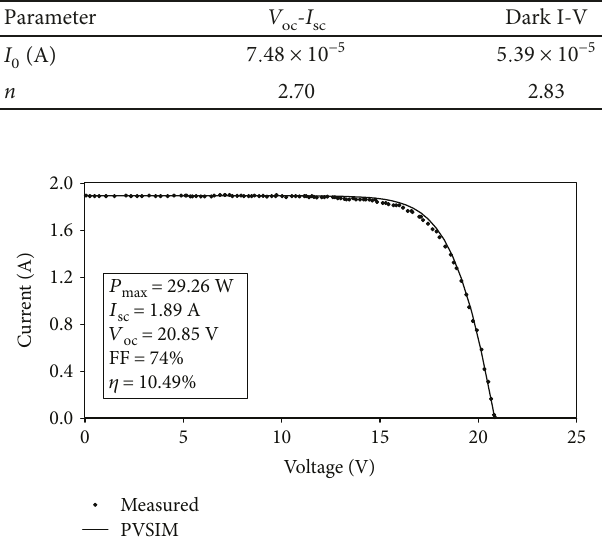
- I measurements compared to oc sc